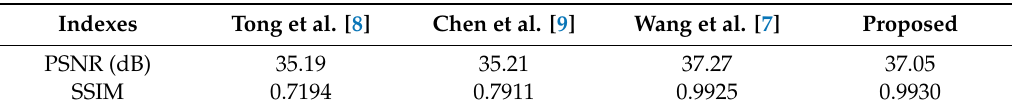
Figure 11. Partially enlarged details of restored images: ( a ) details in Reference [8]; ( b ) details in Reference [9]; ( c ) details in Reference [7]; ( d ) details in the proposed method. Table 5. Objective comparison of the recovery performance for the image deletion attack on the Venice image.